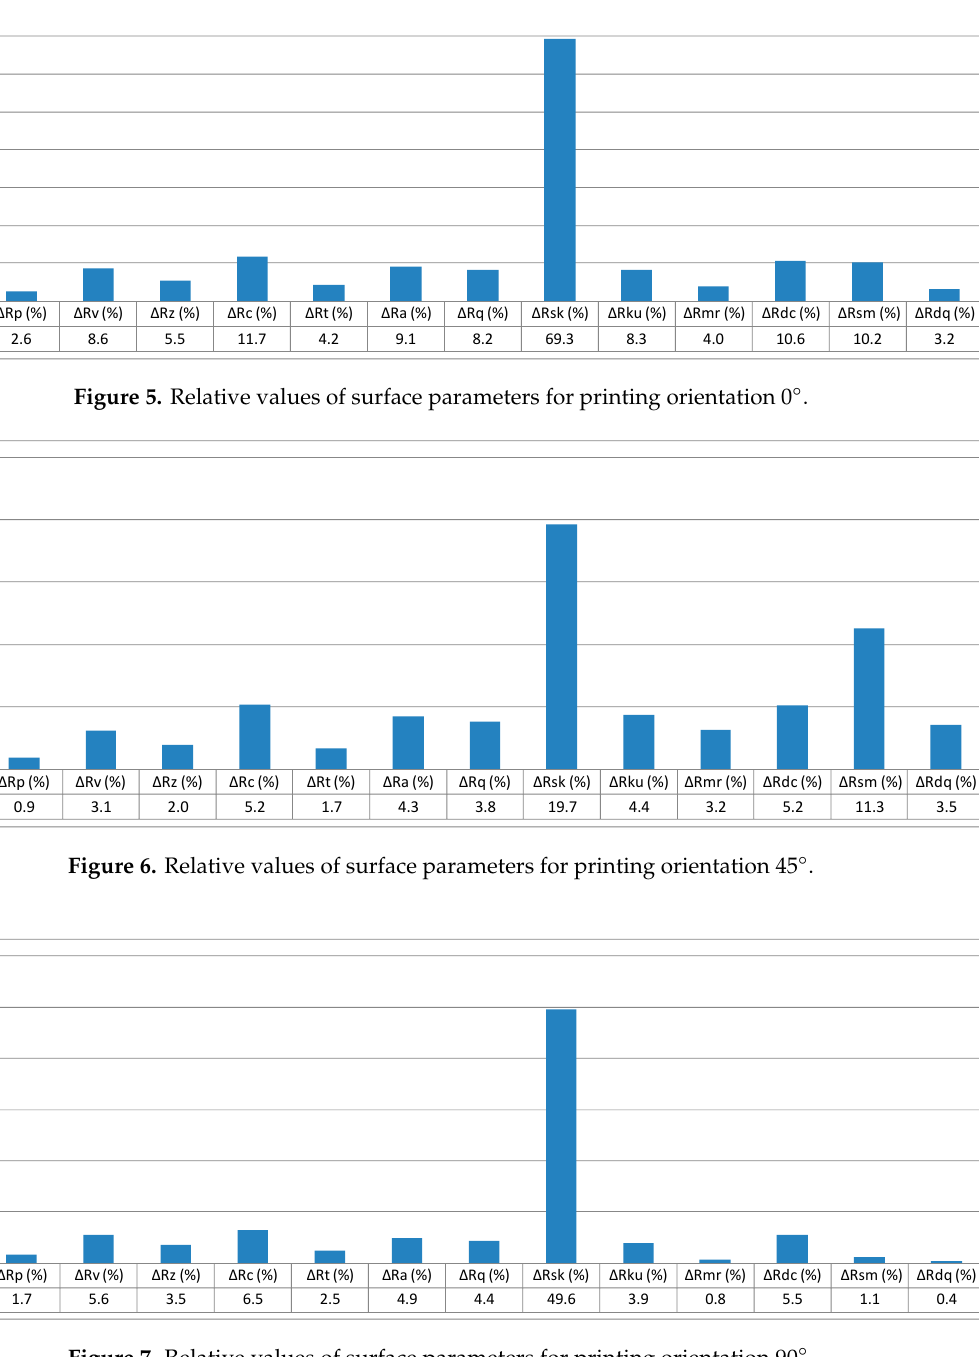
Figure 7. Relative values of surface parameters for printing orientation 90°.